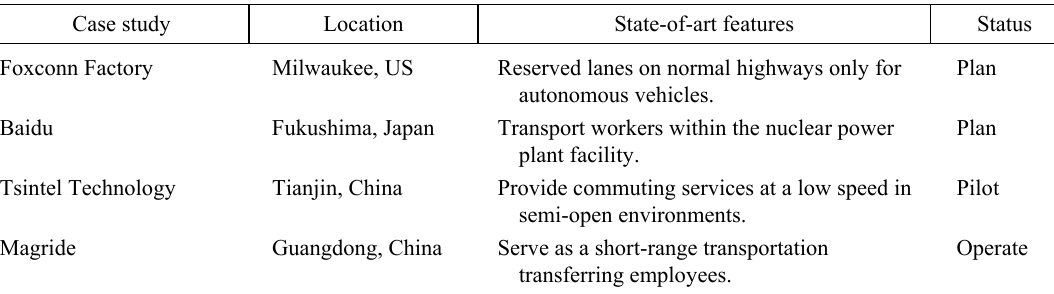
Table 1. Comparison of shuttle buses developed worldwide Case